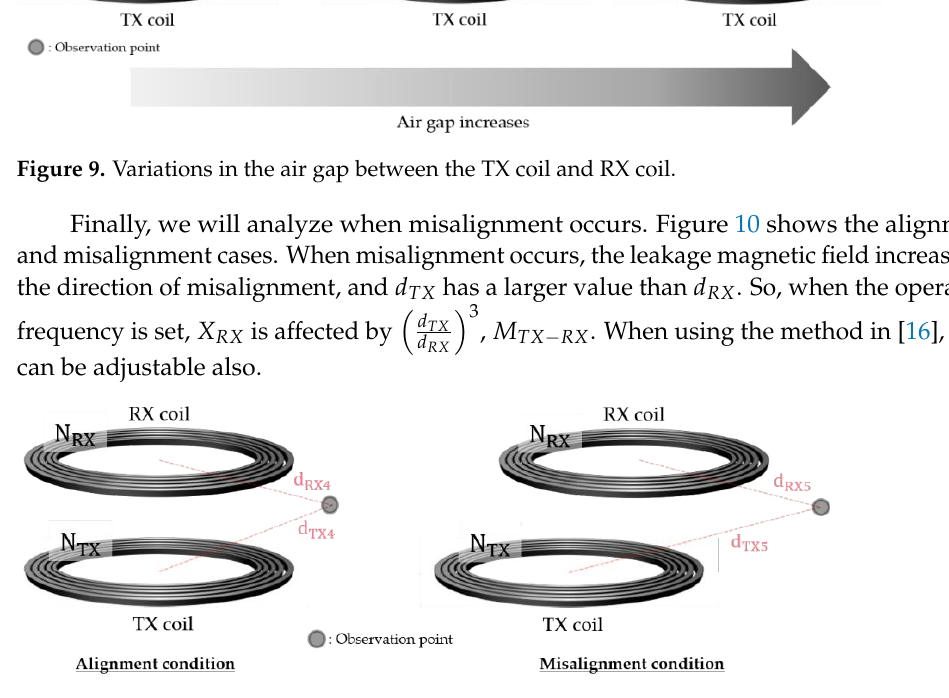
Figure 10. Misalignment condition between the TX coil and RX coil.